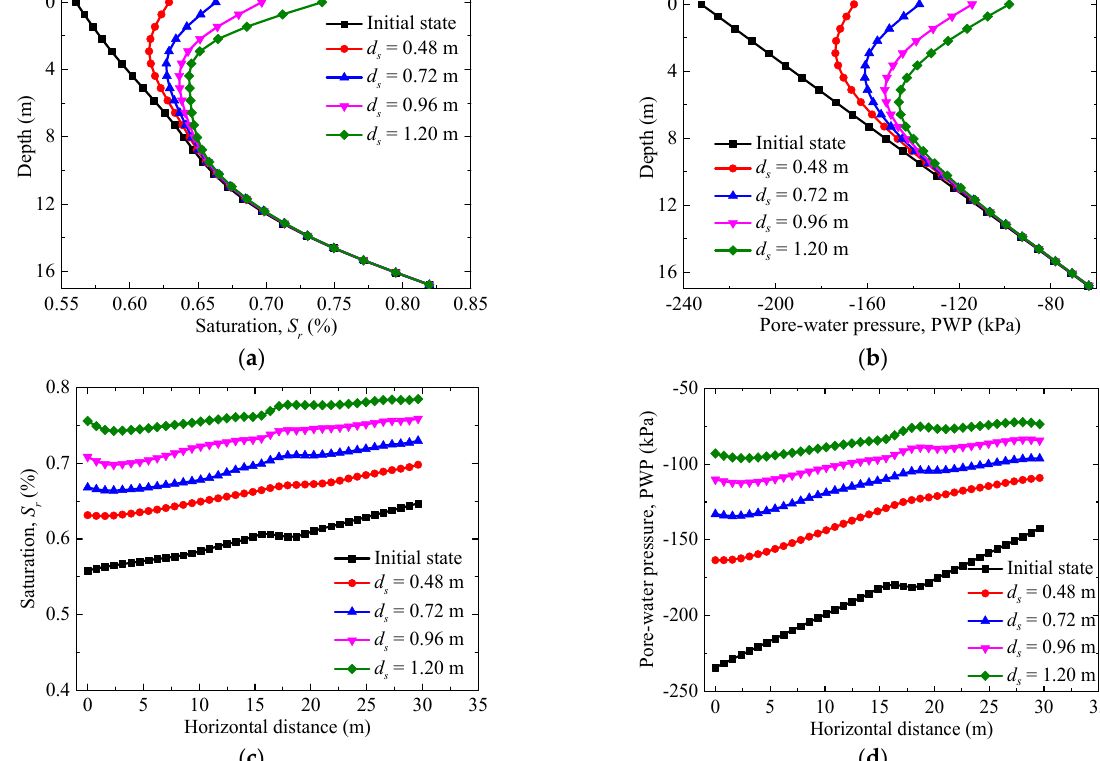
Figure 12. Effect of the depth of accumulated snow ( d s ) on the ( a ) the degree of saturation profile at L1; ( b ) the PWP profile at L1; ( c ) the degree of saturation profile at L2; and ( d ) the PWP profile at L2.